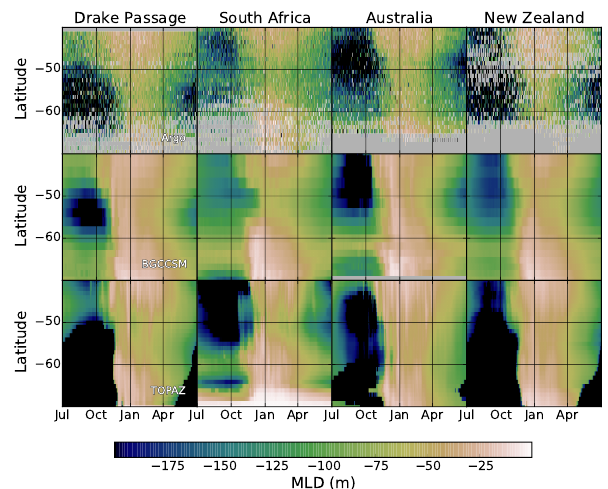
Figure 13. Climatological Hofmøller plots of MLD (m) in different regions of the Southern Ocean. All model values are zonal medians within the box. All observations that fall on a specific grid cell on a specific year day are averaged to one